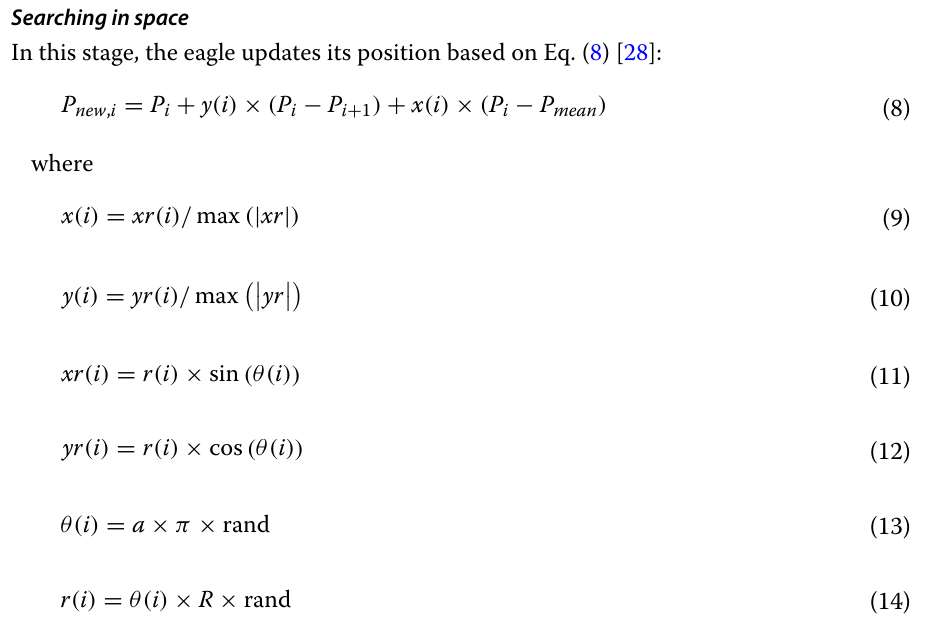
Searching in space